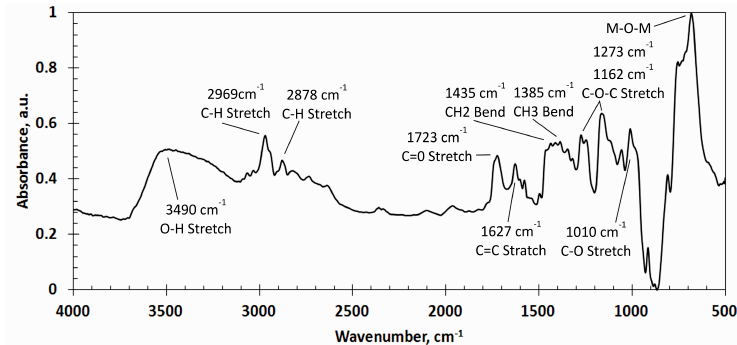
Figure 4. Fourier transform infrared spectroscopy (FTIR) absorbance spectra with functional groups of PZT coating.